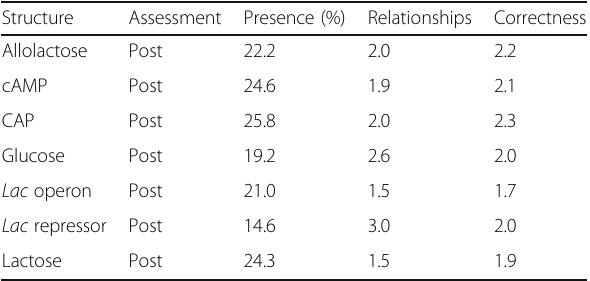
Table 3 Local environment analysis (presence, average number of relationships, and average correctness) of context-specific structures that were not provided in instructions ( n = 329 models). Relationships are the number of labeled arrows connected to the structure and correctness is the quality of those relationships. Only post-lesson models were analyzed because presence on pre-lesson models was below 10%